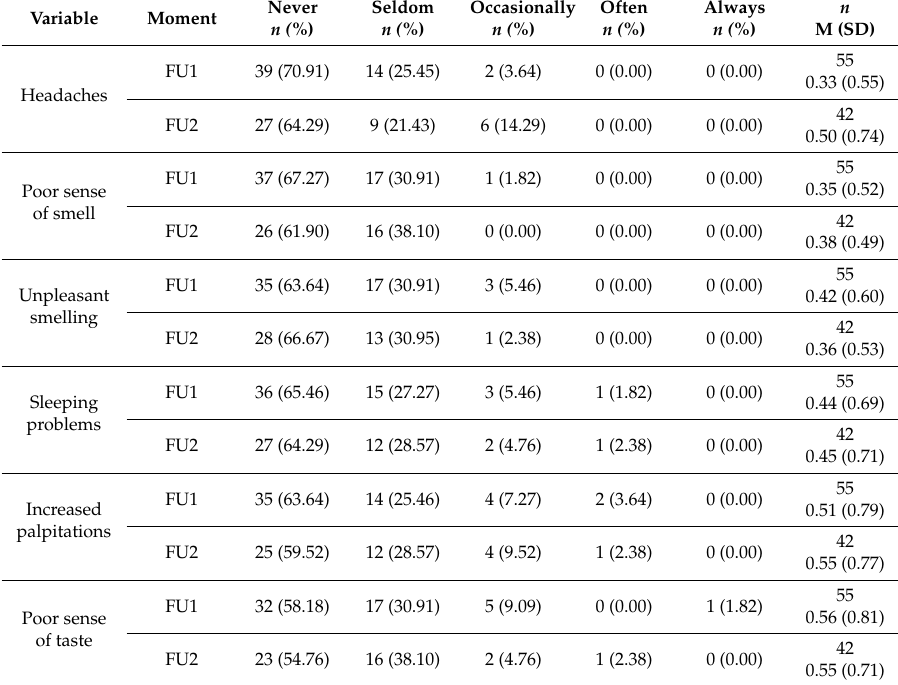
Table A2. Experienced negative health effects from vaping at FU1 and